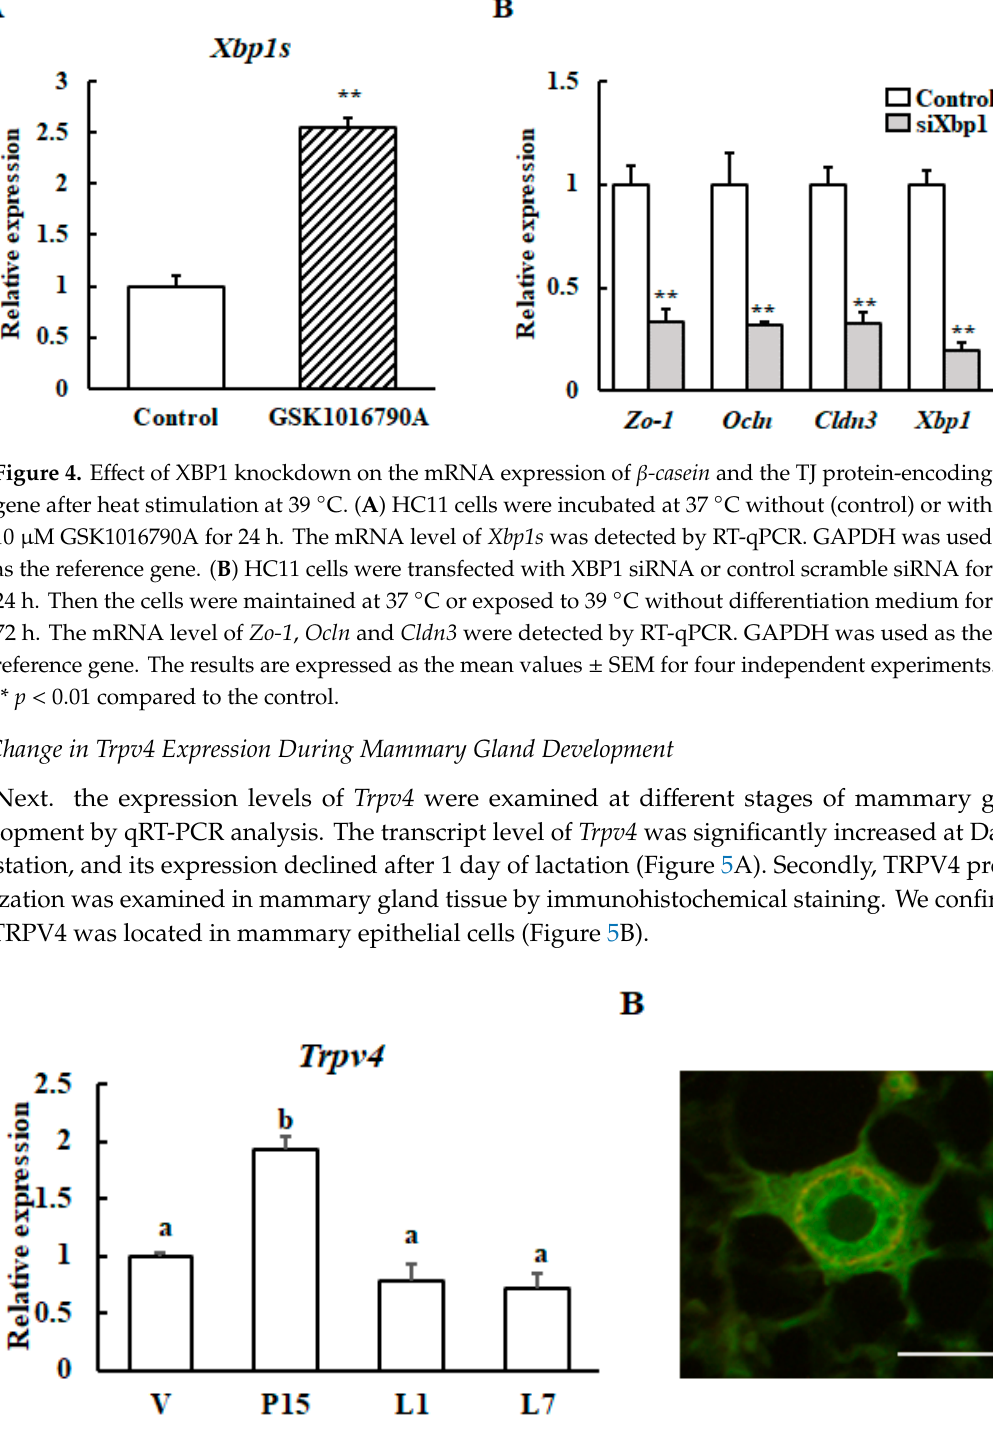
Figure 5. Expression patterns of the Trpv4 gene during mammary gland maturation. ( A ) RT-qPCR analysis of Trpv4 mRNA in the mouse mammary glands during pregnancy and lactation: virgin (V); 15-day pregnant (P15); 1-day lactation (L1); and 7-day lactation (L7). The results are expressed as the mean values ± SEM for four individual mice. Different letters represent significant difference, p < 0.05. ( B ) Immunohistochemical staining of TRPV4 (green) and smooth muscle actin (red) in mammary glands from 10-week-old virgin animals. Scale bar = 50 µ m.